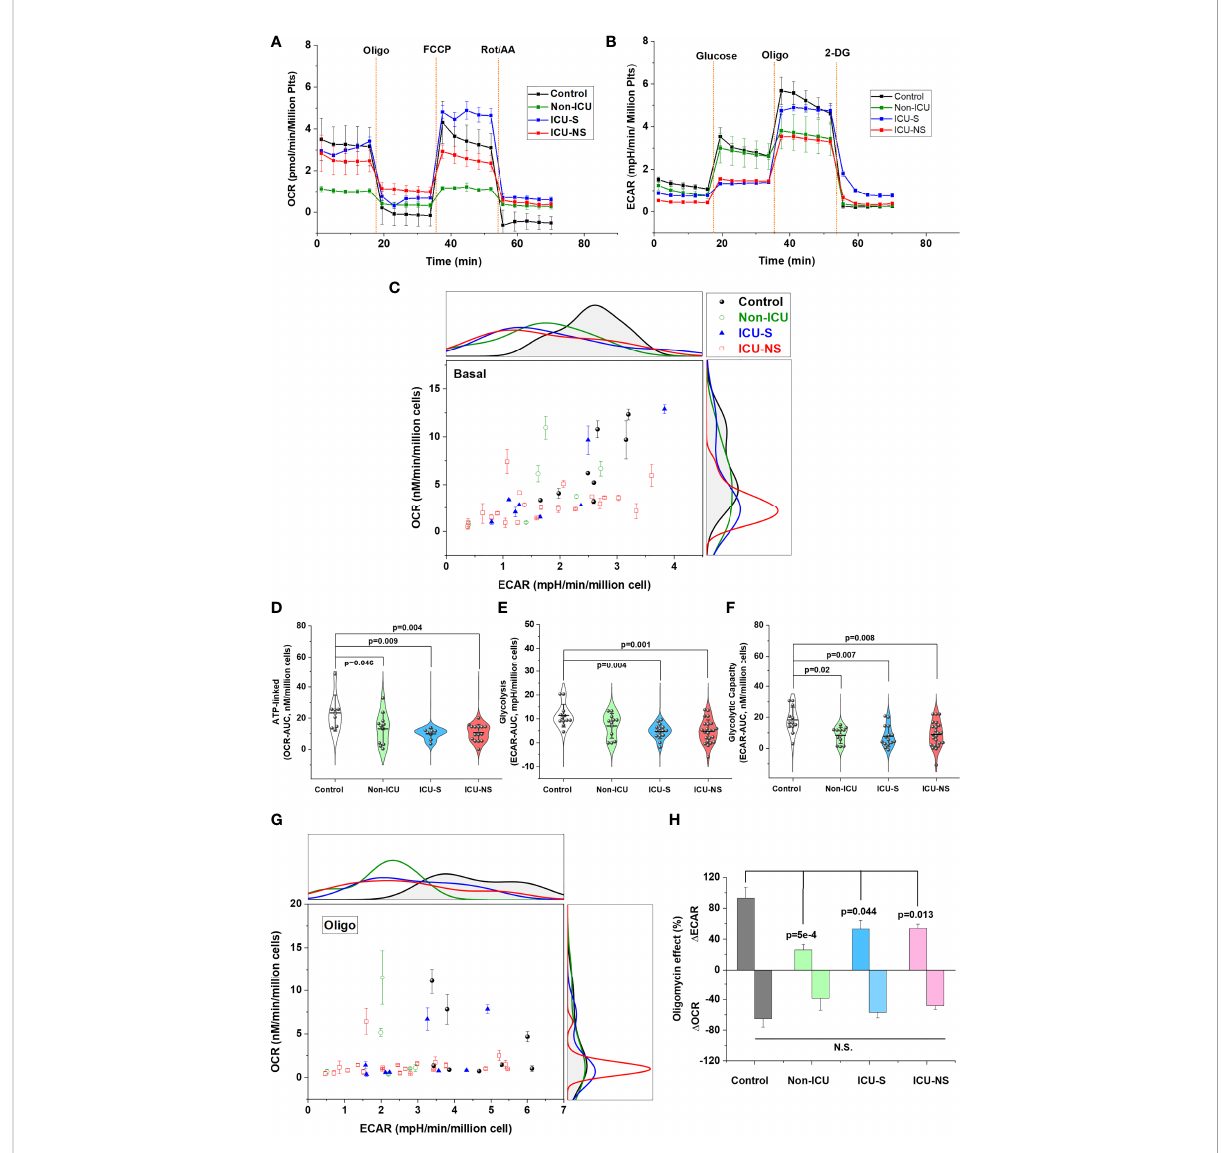
FIGURE 2 Metabolic pro fi ling of isolated platelets showed remarkable metabolic depression and impaired metabolic fl exibility in severe COVID-19 patients. The OCR (aerobic metabolism) (A) and ECAR (glycolytic fl ux) (B) were measured in platelets freshly isolated from control, non-ICU, ICU-S, and ICU-NS and normalized to platelets count. (C) ECAR and OCR data were plotted simultaneously to reveal overall relative basal metabolic pro fi les (no substrate added) for all groups. Metabolic analysis of basal activities showing diminished glycolytic as well as mitochondrial respiratory activities in platelets isolated from ICU-hospitalized COVID-19 patients (n=8, 6, 8, and 21 for control, non-ICU, ICU-S, ICU-NS; respectively). (D) When ATP-linked oxygen consumption were compared for all groups, both non-ICU and ICU groups showed statistically signi fi cant metabolic depression relative to control groups (n=8, 11, 8, and 15 for control, non-ICU, ICU-S, ICU-NS; respectively). Glycolytic metabolism (E) and glycolytic capacity (F) were impaired in patients ’ platelets compared to control platelets (n=12, 11, 15, and 23 for control, non-ICU, ICU-S, ICU-NS; respectively). (G) ECAR and OCR data were plotted concurrently to compare metabolic fl exibility under the inhibition of mitochondrial ATP-synthesis by oligomycin for all groups (n=8, 6, 8, and 21 for control, non-ICU, ICU-S, ICU-NS; respectively). (H) A diagram showing signi fi cantly impaired metabolic switch to glycolytic pathway in COVID-19 patients compared to control ( D ECAR, n=7, 6, 7, and 19 for control, non-ICU, ICU-S, ICU-NS; respectively; D OCR, n=7, 6, 8, and 21 for control, non-ICU, ICU-S, ICU-NS; respectively). Multiple comparisons were carried out using ANOVA followed by Tukey test and p values are